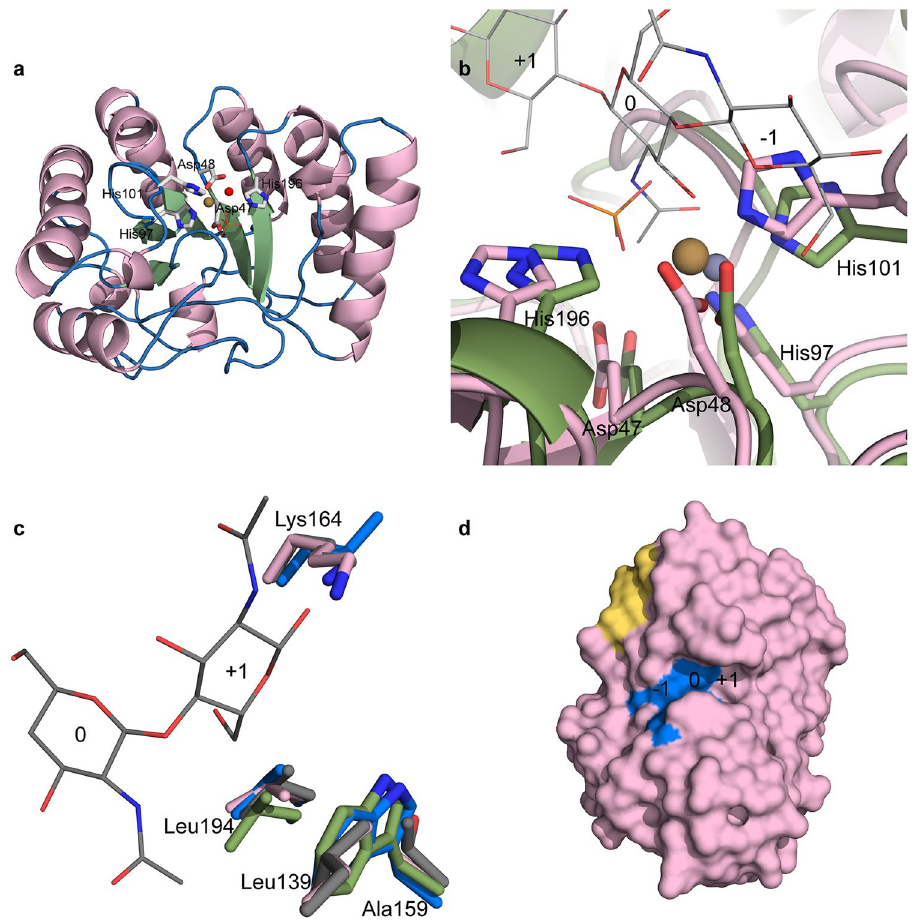
Figure 7. Crystal structure of An CDA. ( a ) Structure of An CDA coloured by secondary structure; green = strand, pink = helix and blue = loop/coil. The side chains of the metal binding residues, the catalytic acid and the catalytic base are labelled and shown as sticks, the phosphate ion is shown as orange lines, and the metal ion is shown as a brown sphere. The water ion participating in the octahedral arrangement of the metal is shown as a red sphere. ( b) Structural superposition of A nCDA (pink) and Vc CDA (green; PDB id: 4OUI) 18 with a (GlnNAc) 3 (grey lines) in the active site. The side chains of the metal binding His-His-Asp triad and the catalytic acid and base are shown as sticks, with numbering according to An CDA. The phosphate ion in the An CDA structure is shown as orange sticks. Subsites are labelled − 1, 0, and + 1. The brown sphere is the Co 2 + ion bound in An CDA, while the dark grey sphere is the Zn 2 + ion bound in Vc CDA. The structural superposition was generated using the PyMod 2.0 51 plugin in PyMol. ( c ) Structural differences around subsite + 1 in An CDA (pink), Vc CDA (green), Sp PgdA (blue; PDB id: 2C1G) 15 , and Cl CDA (grey; PDB id: 2IW0) 9 , showing the sidechains (in sticks) of the residues forming the hydrophobic pocket and the lysine special for An CDA and Cl CDA (see text). The ligand is shown as thin lines with grey carbons. At the position of Leu139 in An CDA, Cl CDA also has a leucine (shown), while Sp PgdA has a glycine and Vc CDA has a threonine (both not shown). At the position indicated by Ala159 in An CDA, Cl CDA has a threonine whereas the other two CDAs have a tryptophan (all shown). At the position indicated by Leu194 in An CDA, the other three CDAs also have leucine (all shown). At the position indicated by Lys164 in An CDA, Cl CDA also has a lysine, whereas Sp PgdA and Vc CDA have leucine (shown) and alanine (not shown), respectively. ( d) Surface representation of An CDA, showing the active site residues (H97, H101, D48, D47, H196) in blue with subsite numbering. The yellow area corresponds to the hydrophobic patch (Y53, Y200, W201) discussed in the